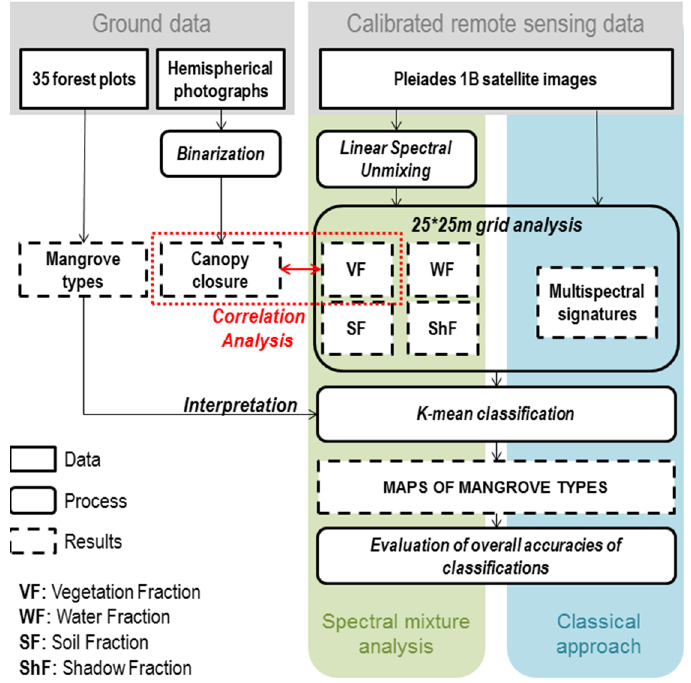
Figure 2. Flowchart of data processing in mangrove mapping.